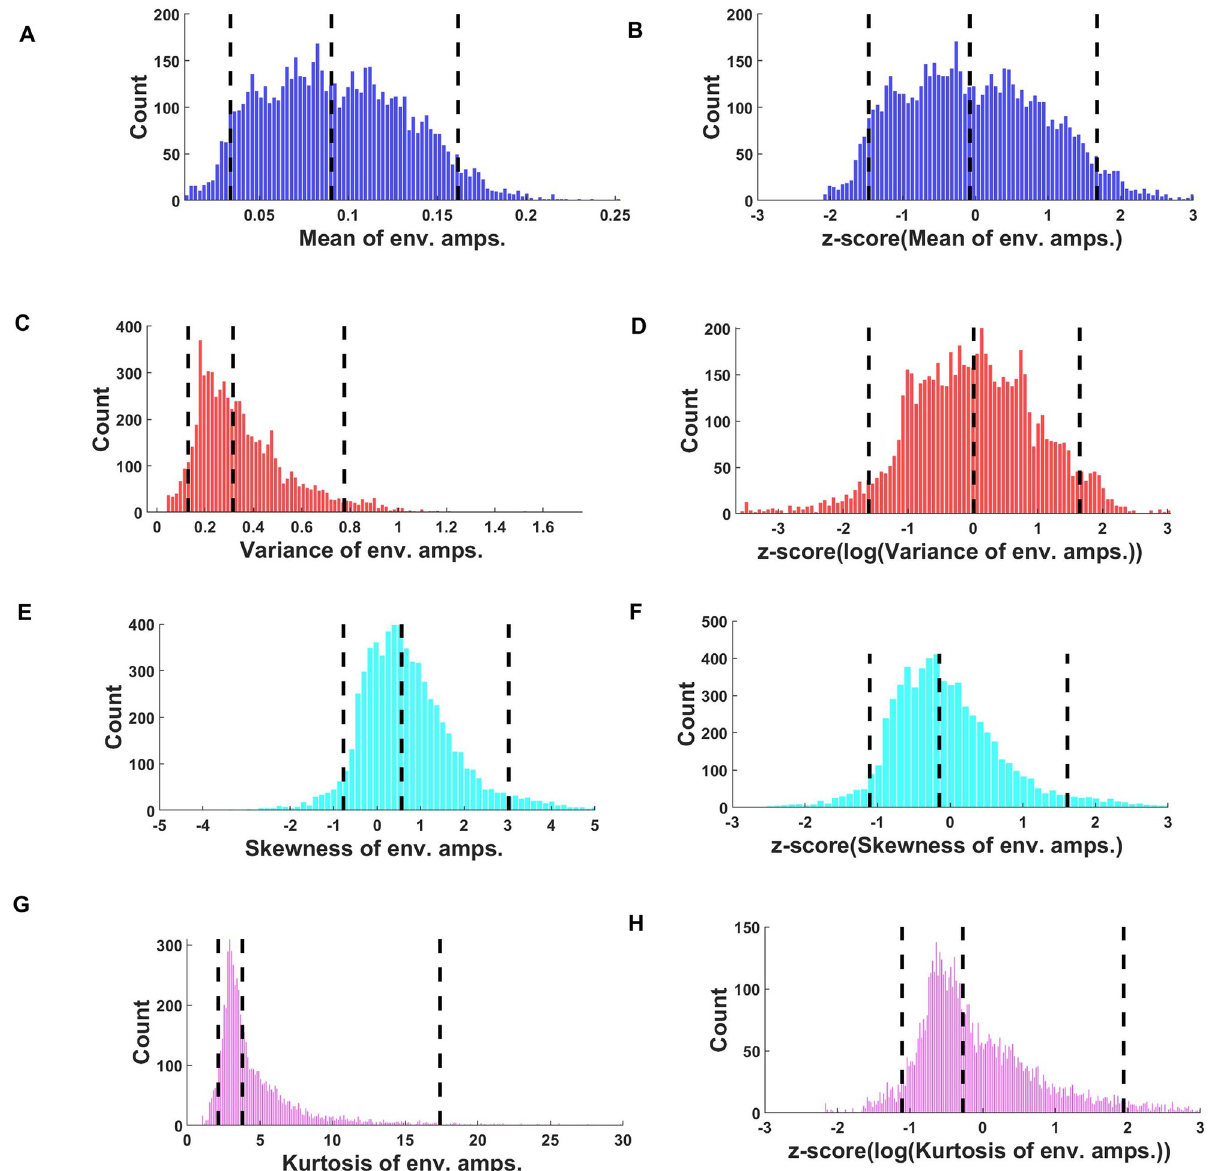
Fig 2. Distribution of statistical parameter values for the entire corpus. (A, B) Distribution of mean of envelope amplitudes. The median, 5th and 95th centiles of the distributions were 0.09, 0.034 and 0.16 respectively. (B) Mean of envelope amplitudes after z-scoring. (C) Distribution of variances of envelope amplitudes. The median, 5th and 95th centiles were 0.31, 0.13 and 0.77 respectively. (D) Variances of envelope amplitudes after log transformation and z-scoring (E) Distribution of skew of envelope amplitudes. The median, 5th and 95th centiles were 0.56, -0.77 and 3.0 respectively. (F) Skew of envelope amplitudes, after z-scoring. (G) Distribution of kurtosis of envelope amplitudes. The median, 5th and 95th centiles were 3.79, 2.13 and 17.4 respectively. (H) kurtosis of envelope amplitudes after log transformation and z-scoring. Black dotted lines in each panel show the 5th percentile, median, and the 95th